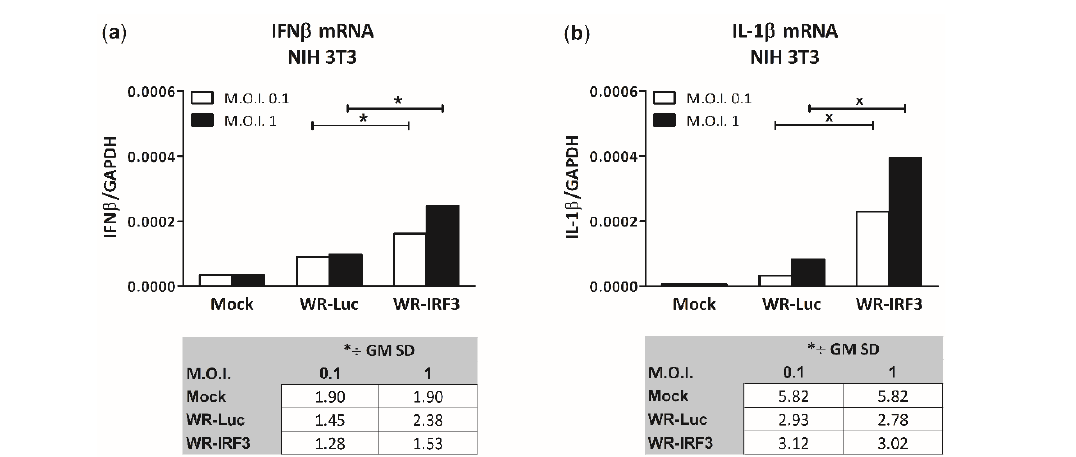
Figure 3. Infection with WR-IRF3 increases mRNA levels of ( a ) IFN β and ( b ) IL-1 β in NIH 3T3 fibroblasts. The cells were mock-infected or infected with WR-Luc or WR-IRF3 at M.O.I. of 0.1 and 1. At 24 h.p.i., the cells were collected and used for 1-step RT-qPCR analysis. IFN β and IL-1 β mRNA was normalized to GAPDH mRNA and expressed as GM * ÷ SD; n = 4. Statistically significant differences at x p < 0.1, * p < 0.05 (one-tailed unpaired Student’s t-test). Mock, mock-infected cells; WR-Luc, cells infected with VACV expressing luciferase; WR-IRF3, cells infected with VACV expressing Mu IRF-3.